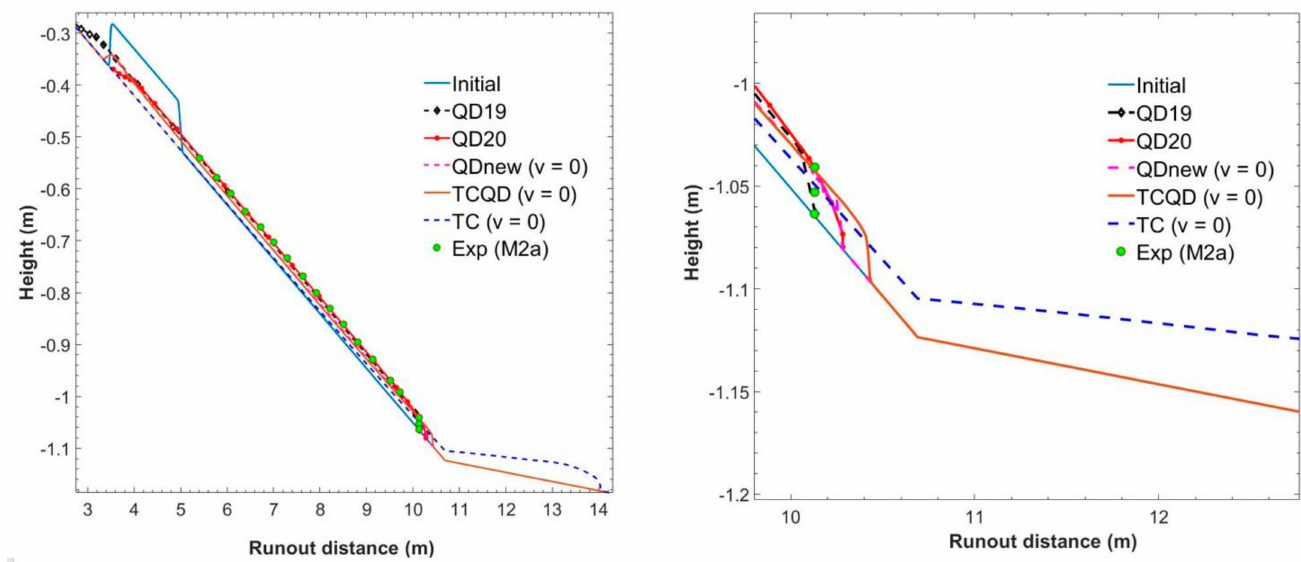
Figure 4. Comparison of debris-flow height between experimental and numerical data sets for case M3a (“Exp.” data from Mohrig et al. [35]; “Num. QD19, QD20” data from Qian and Das [7], Qian et al. [1],